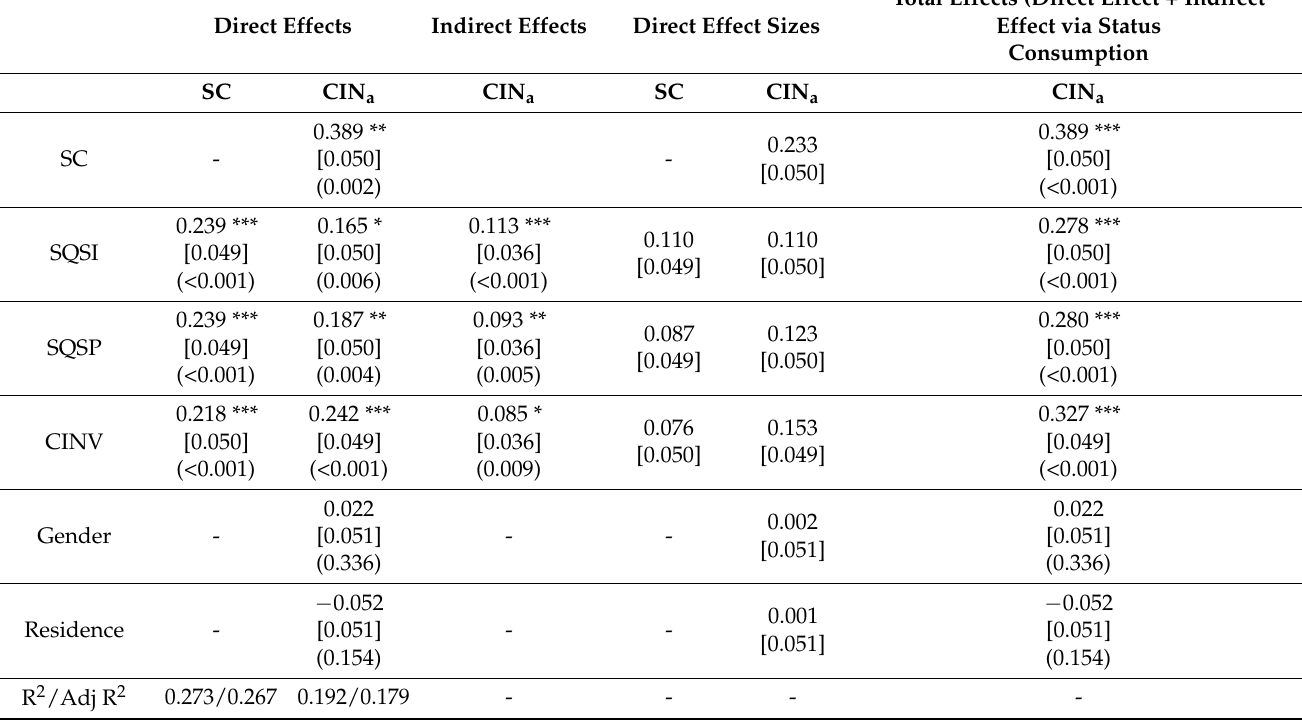
Table 10. The second structural equation model.